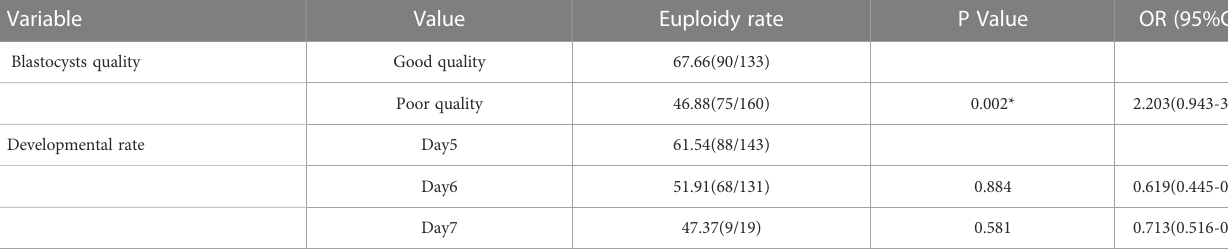
TABLE 1 Blastocyst biopsy results of PGT-A group.